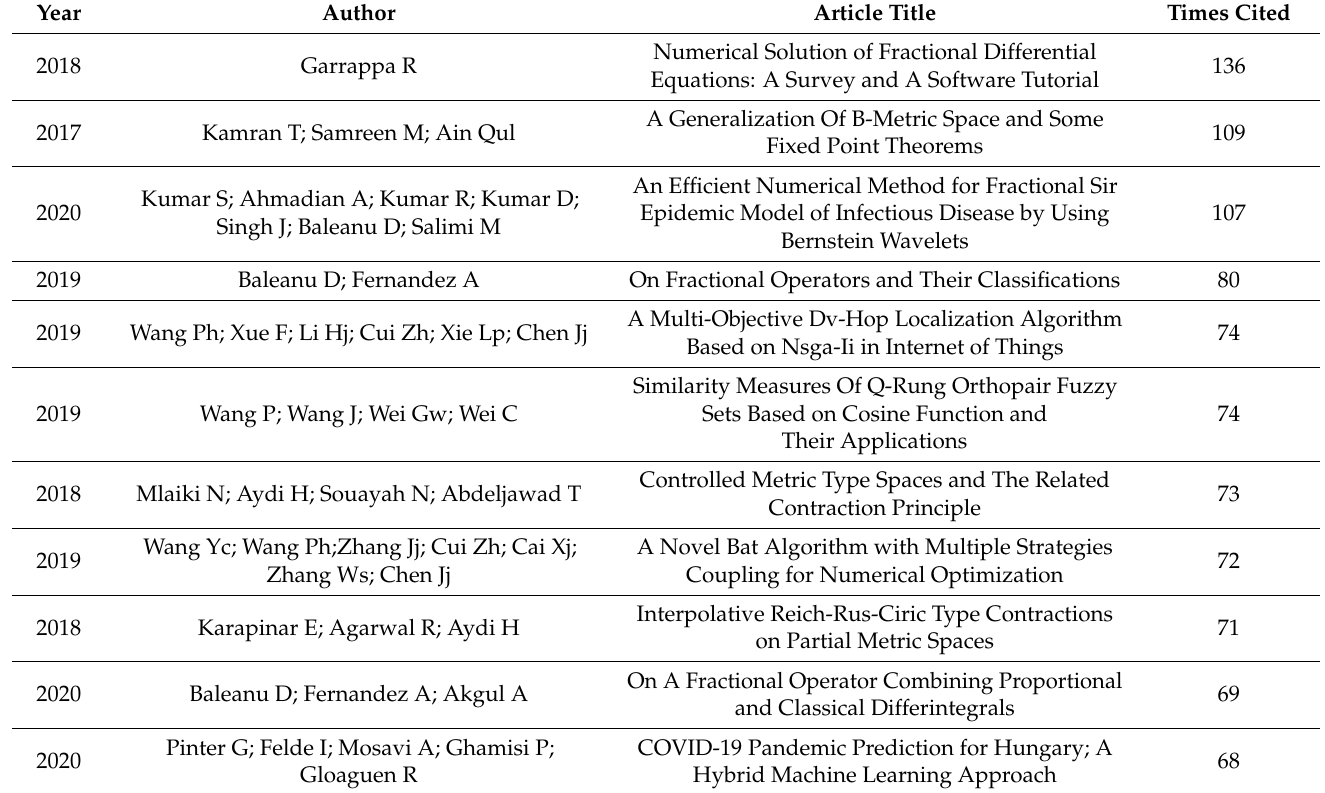
Table 3. Most cited papers in the Mathematics journal based on the WOS times cited